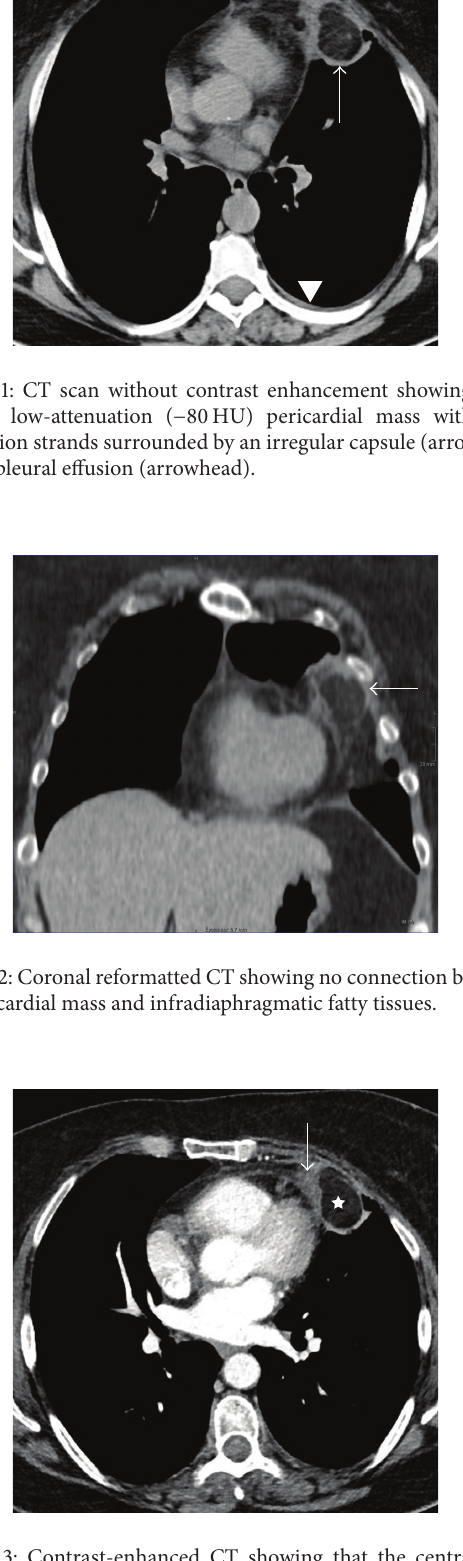
Figure 3: Contrast-enhanced CT showing that the central fatty attenuation of the mass is not enhanced (star); the capsule shows a 50HU increase in density (arrow).